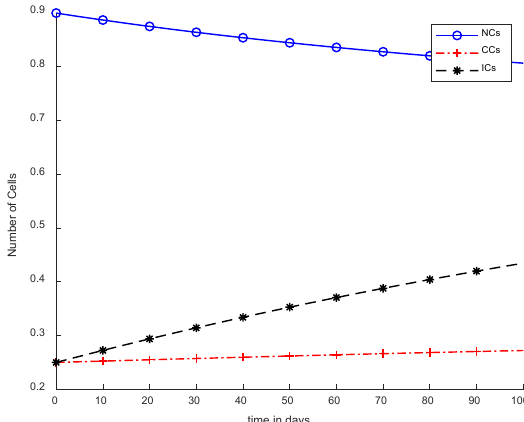
Figure 4. Without chemotherapy and controllers.